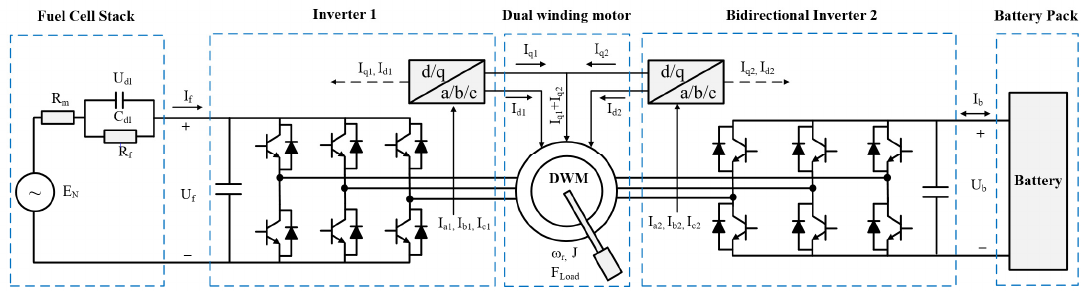
Figure 3. System architecture of the DWM drive system for fuel cell vehicle.